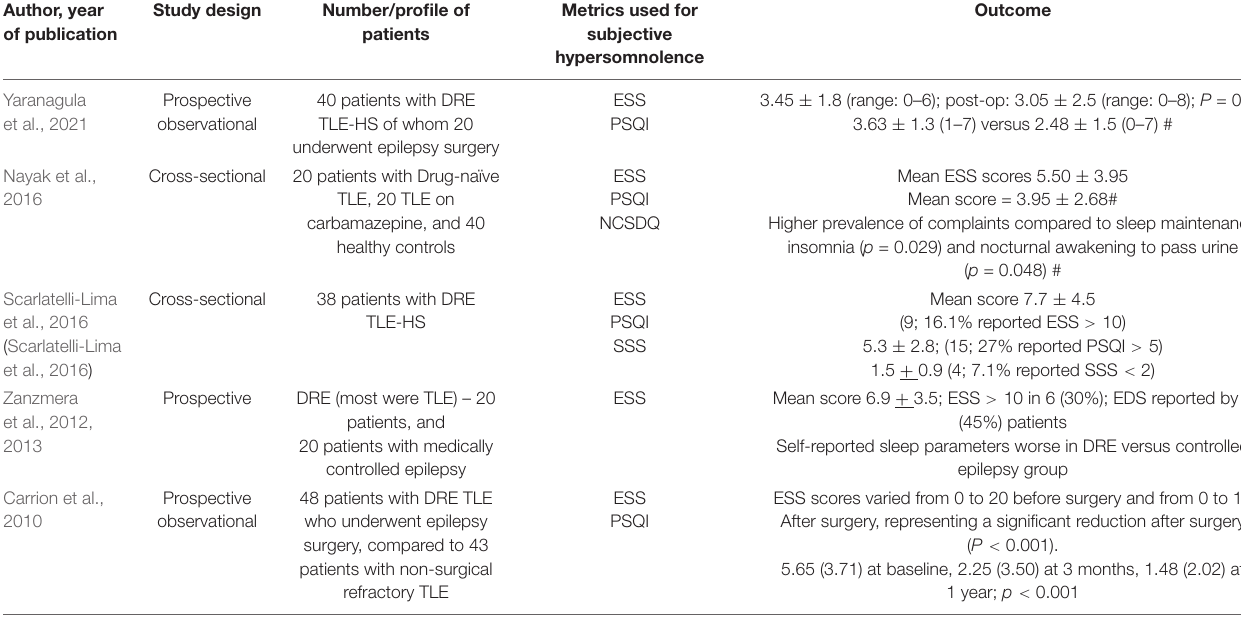
TABLE 3 | Studies assessing subjective hypersomnolence among persons with